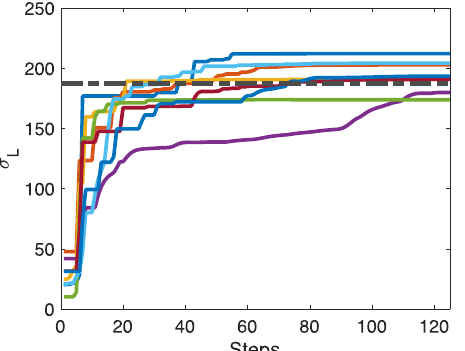
Fig. 7 Inference for different copies of trajectories. The plot shows the inferred value of the entropy production rate σ L as a function of the number of steps in the optimization algorithm, using the linear basis. The data is shown for different data sets all spanning 12.5 s in total length, generated numerically for the same parameter choices as in Fig. 1b. The black dashed line corresponds to the theoretical estimate of the entropy production rate σ for this